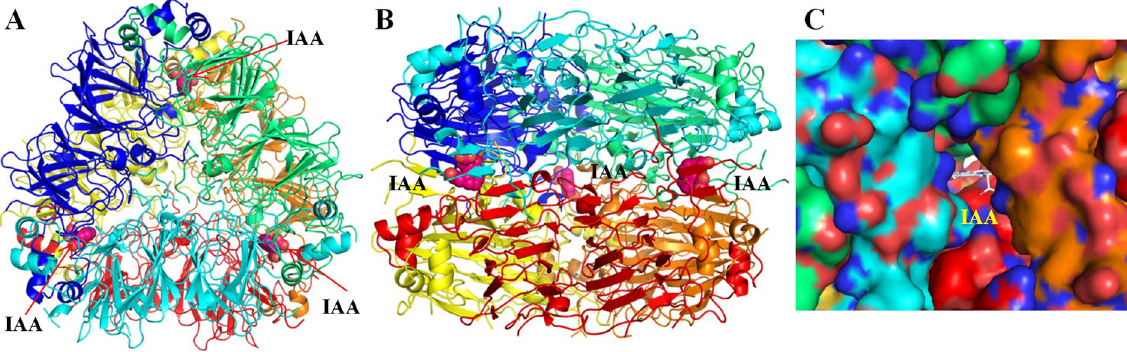
Figure 3. The auxin-binding site architecture. ( A ) The WTG hexamer showing three symmetrical auxin binding pockets each formed by four WTG monomers. ( B ) The side view of WTG hexamer showing auxin binding pockets sandwiched between two trimers. The auxin is shown as pink spheres whereas WTG hexamer is shown in cartoon representation. All the chains have been shown in different colours - chain A (blue), chain B (green), chain C (cyan), chain D (yellow), chain E (red), and chain F (orange). ( C ) Surface view of WTG tetramer demonstrating the size and shape of the auxin-binding pocket with auxin shown in white sticks. All the C-alpha atoms of different chains have been shown in different colors - chain A (blue), chain B (green), chain E (dark red), and chain F (orange) in surface view. The light red and dark blue color show surface of oxygen and nitrogen in all the four chains.